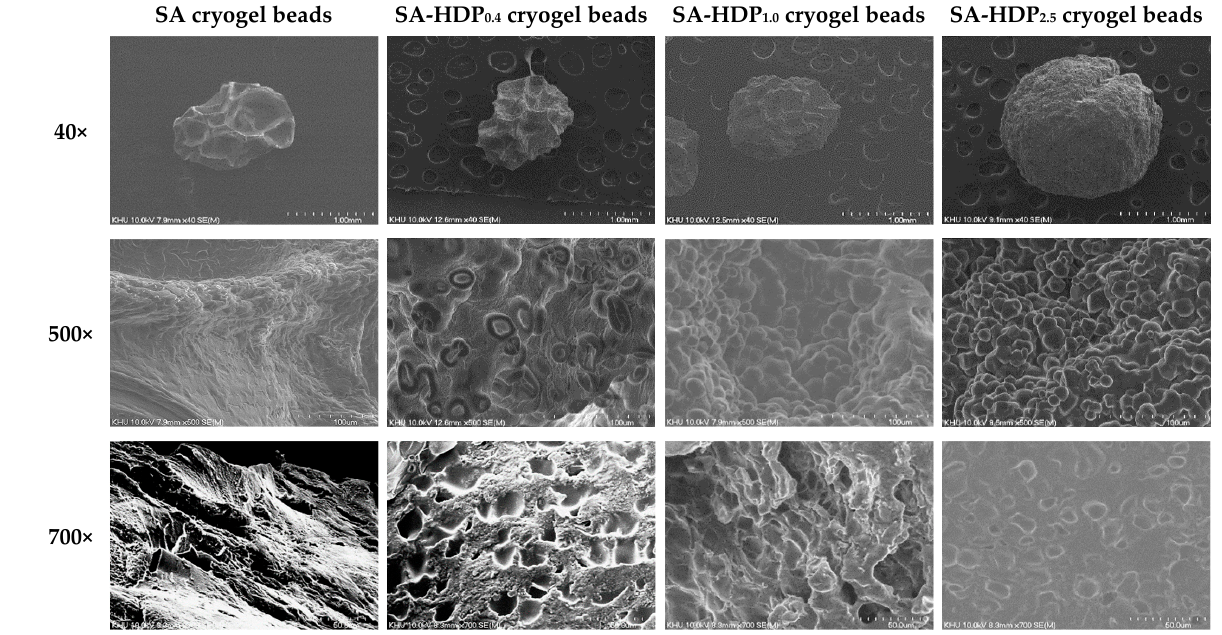
Figure 1. Scanning electron microscope (SEM) images of sodium alginate (SA)-based cryogel beads filled with different concentrations of hydroxypropyl distarch phosphate (HDP): overall morphologies (40×), surface morphologies (500×), cross-section morphologies (700×). SA cryogel beads, SA-HDP 0.4 cryogel beads, SA-HDP 1.0 cryogel beads, and SA-HDP 2.5 cryogel beads represent cryogel beads filled with different concentrations of HDP (0, 0.4, 1.0, and 2.5%, respectively). The overall morphology (40×) of SA cryogel beads showed a non-spherical shape